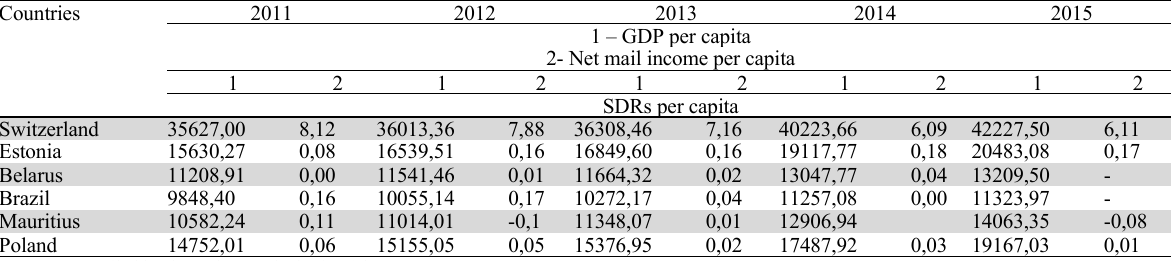
Fig. 3. Ranking of the countries-leaders of different regions on the effectiveness of mail Table 3 Comparative performance of postal